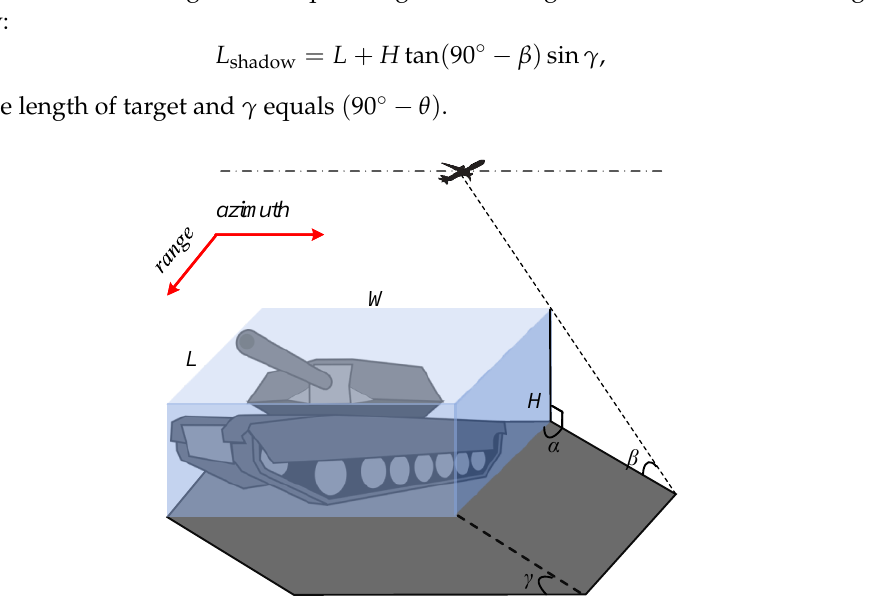
Figure 2. Schematic illustration of shadow size. The blue box and the gray plane represent the target and its shadow,